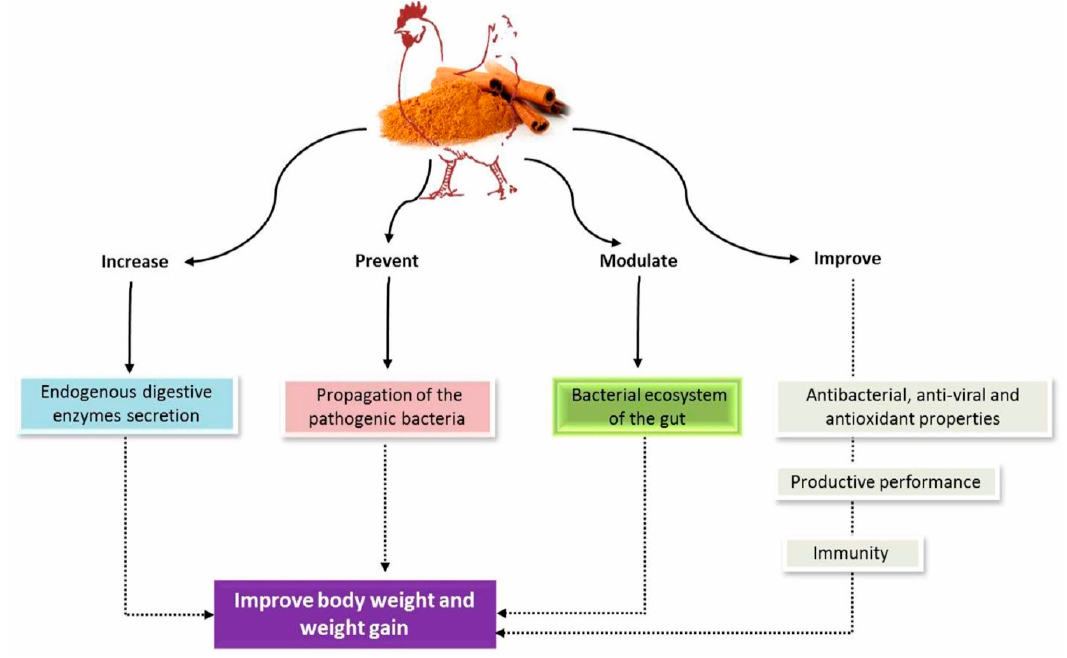
Figure 2. The effect of cinnamon oil on body weight and weight gain. Figure 2. The e ff ect of cinnamon oil on body weight and weight